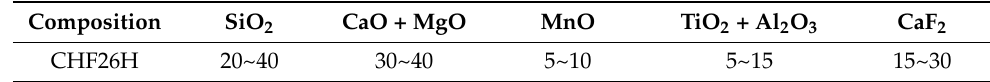
Table 2. Chemical composition of welding flux